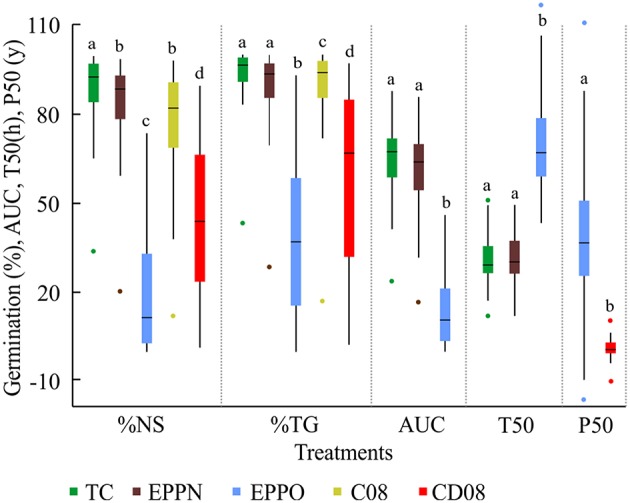
Germination performance of 94 Oregon Wolfe Barley (OWB) lines after different storage treatments tested in 2008 and 2011. Germination performance is expressed as the percentage of normal seedlings (NS%), total germination (TG%), area under the curve (AUC), time to 50% germination (T50 in hours), and half-viability period (P50 in days). Boxplots show minimum and maximum values (spots), 25% and 75% quartiles, and whiskers of the 1.5 interquartile range. Color code is given in the figure. C08, control performed in 2008; CD08, controlled deterioration performed in 2008; EPPN, elevated partial pressure of nitrogen storage; EPPO, elevated partial pressure of oxygen storage; TC, treatment control at ambient air pressure. a, b, c, and d symbolize significant differences between treatments at P < 0.05.